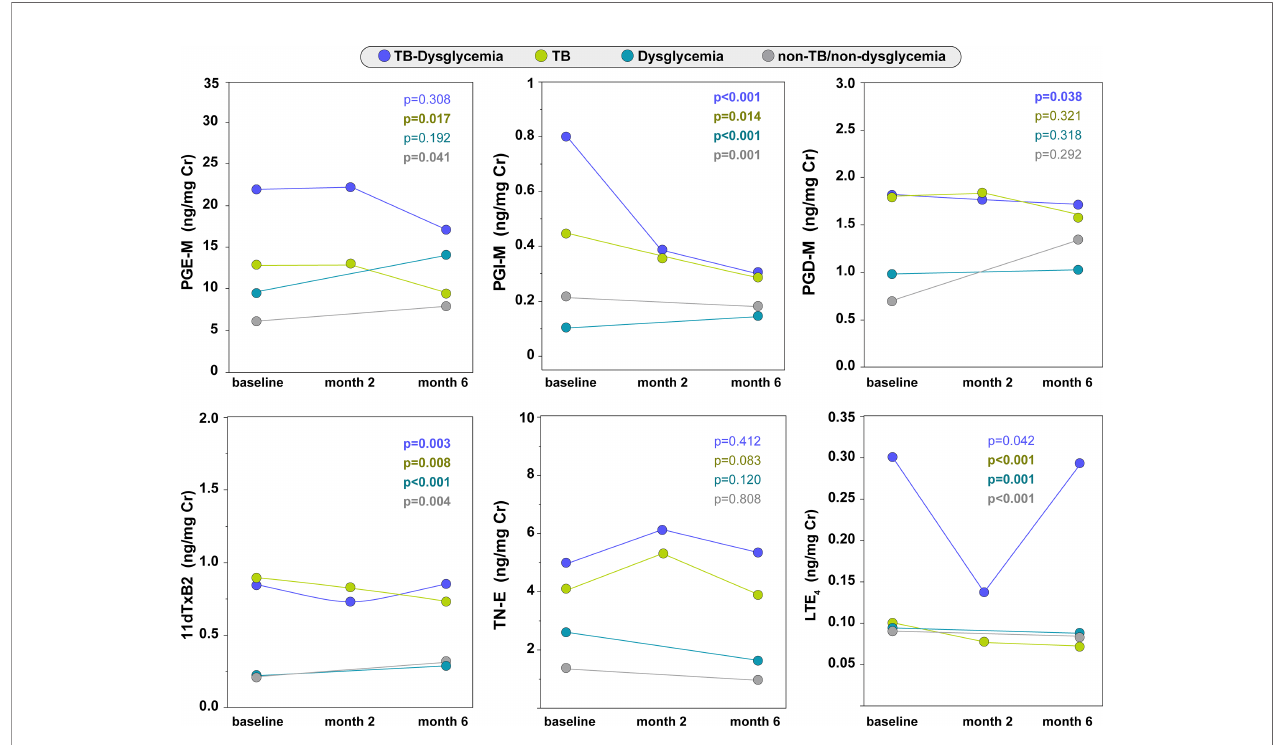
FIGURE 2 | Urinary eicosanoids levels through of study timepoints. Distribution of eicosanoids (each point represents group medians) in TB-dysglycemia, TB, dysglycemia and non-TB/non-dysglycemia groups across study visits. Timepoints were compared using Friedman or Wilcoxon test (when corresponding). Individuals without TB (Dysglycemia and non-TB/non-dysglycemia groups) had only two visits (baseline and month 6). Details of central dispersion and tendency of the data are shown in the Table S2. TB, tuberculosis; PGE-M, major urinary PGE 2 metabolite; PGD-M, major urinary PGD 2 metabolite; PGI-M, 2,3-dinor-6-keto-PGF 1 a (PGI 2 Metabolite); 11dTxB2, 11-dehydro-thromboxane B 2 (TxB 2 urinary metabolite); TN-E, tetranor-PGE 1 (urinary PGE 2 metabolite); LTE 4 , Leukotriene E 4